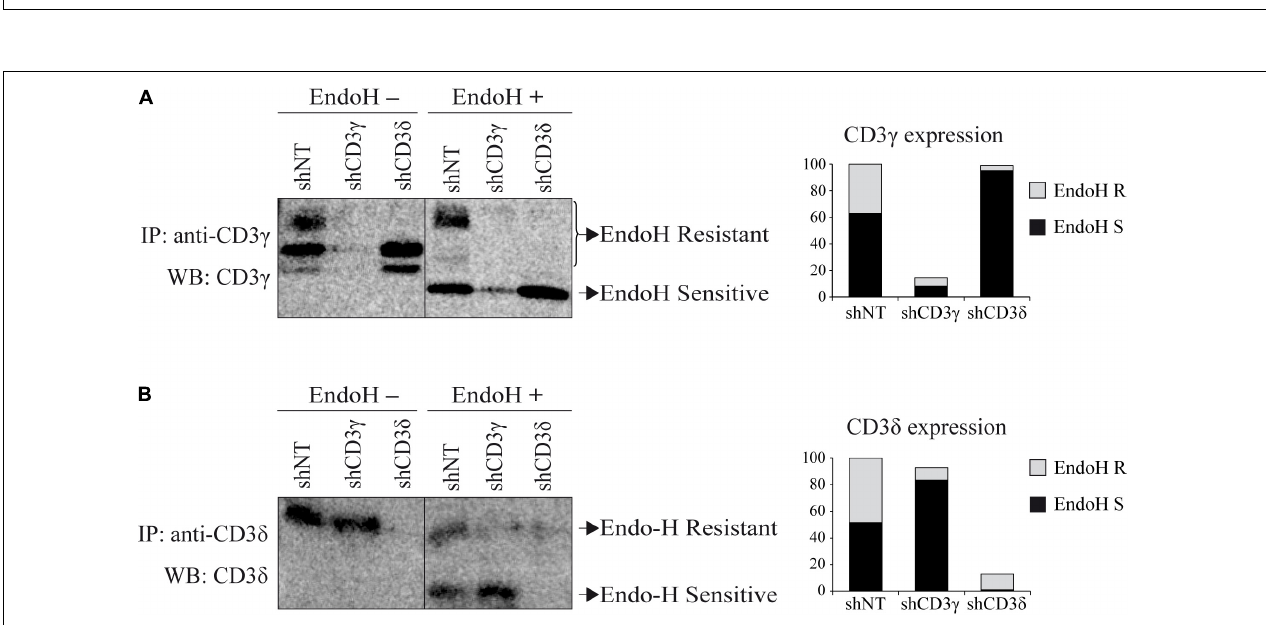
FIGURE 3 | Co-IP of TCR β and CD3 chains in CD3G or CD3D KD T-cell lines. Cells were lysed in Brij96V buffer, and 3 mg of total protein was immunoprecipitated (IP) with the anti-TCR β mAb JOVI-1; the immunoprecipitates and whole lysates were resolved in 15% SDS-PAGE gels, transferred into PVDF membranes, and immunoblotted with antibodies against alpha tubulin and CD3 ε in (A) , CD3 δ in (B) , or CD3 γ in (C) . Analysis and numbers as in Figure 1 . (D) Quantification of three different experiments; data are mean values + SD.